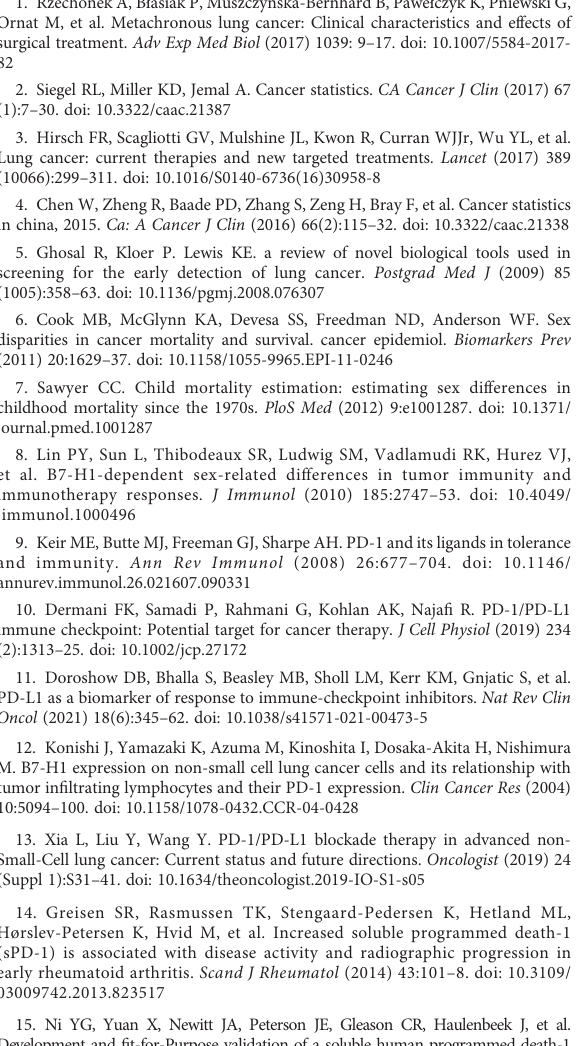
SUPPLEMENTARY FIGURE 5 Correlation analysis of the expression of mPD-1 and ER/AR on T cells. (A) Correlation between the expression of ER and mPD-1 on CD3 T cells, CD4 Tcells, andCD8Tcellsfromnon-smallcelllung cancer(NSCLC)and control subjects. (B) Correlation between the expression of AR and mPD- 1 on CD3 T cells, CD4 T cells, and CD8 T cells from NSCLC and control subjects. (C) Correlation between the expression of ER and AR on CD3 T cells, CD4 T cells, and CD8 T cells from NSCLC and control subjects. P - values were obtained by two-tailed Spearman ’ s test. Linear regression analysis was performed in GraphPad Prism to get the R 2 and P -values. R 2 , goodness of fi t; P , signi fi cance of the slope deviation from zero; NS, non- signi fi cant ( n =